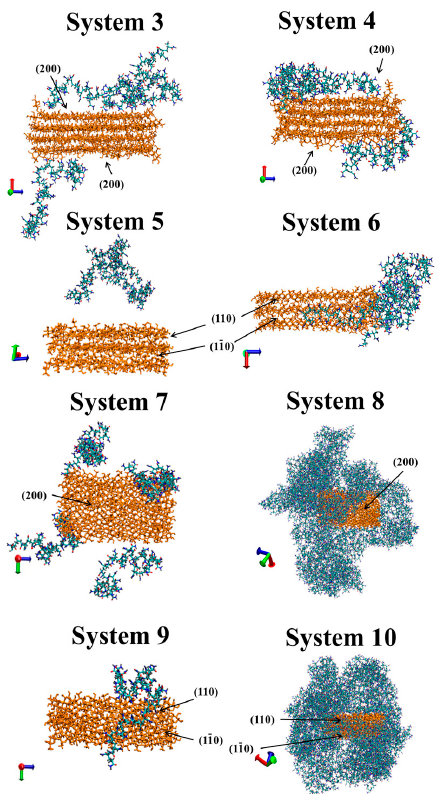
Figure 6. Snapshots of the last frame for Systems 3–10. The water molecules from Systems 3, 5, 7, and 9 were removed to highlight CNC (orange) and PAM. For better understanding, the hydrophobic (200) and hydrophilic (110, 1–10) facets are marked.